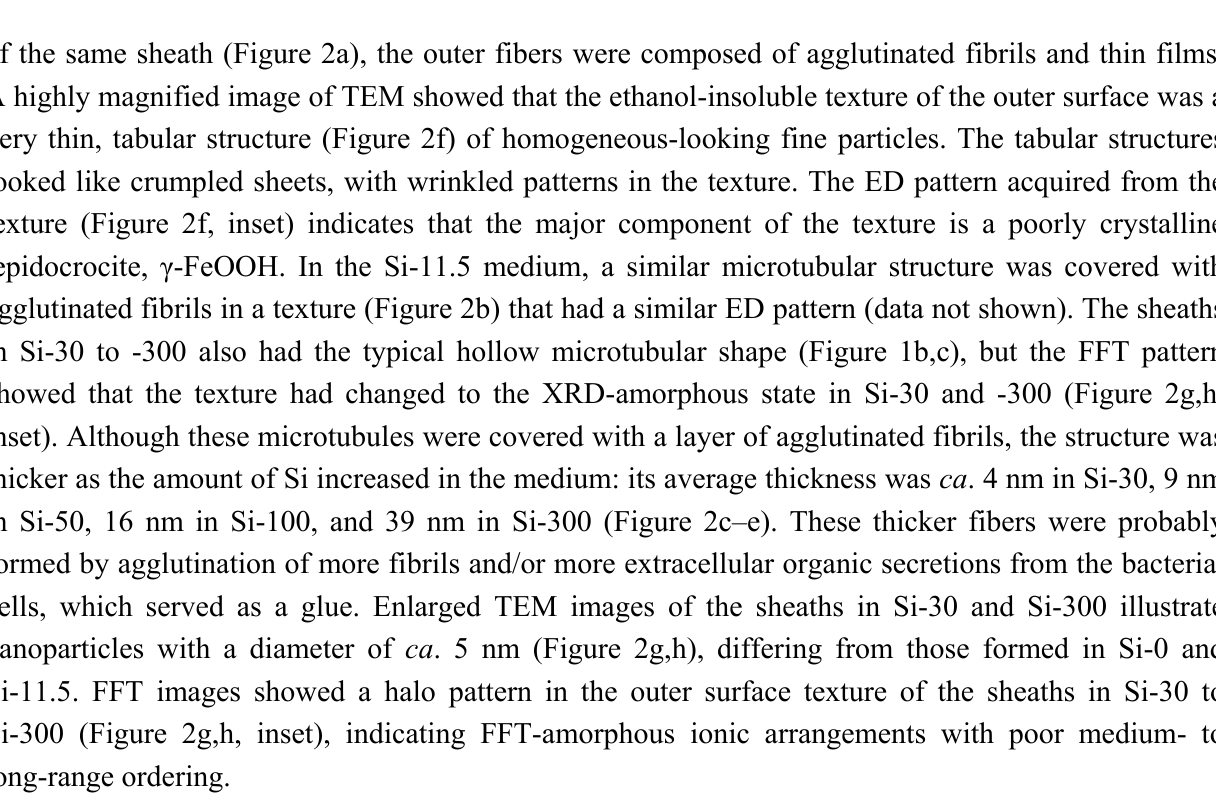
Figure 1. Scanning transmission electron microscopy (STEM) images of cultured sheaths having different Si composition ratios. Secondary electron images (( a ) Si-0, ( b ) Si-30, ( c ) Si-300)) and high-angle annular dark field (HAADF) images (( d ) Si-0, ( e )